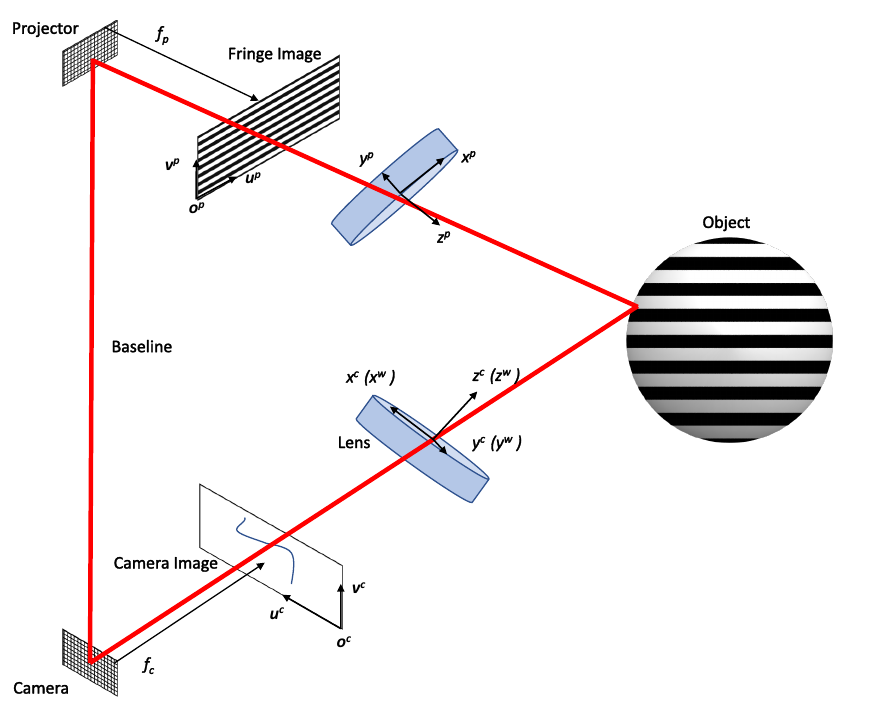
Figure 7. Schematic of structured light